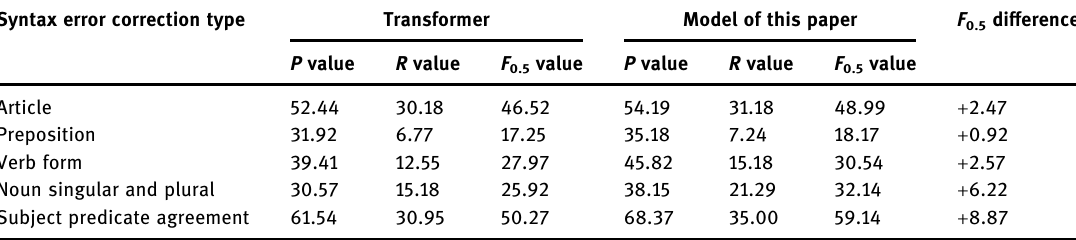
Table 1: Comparative analysis of training results evaluation of CoNLL - 2014 test set Syntax error correction